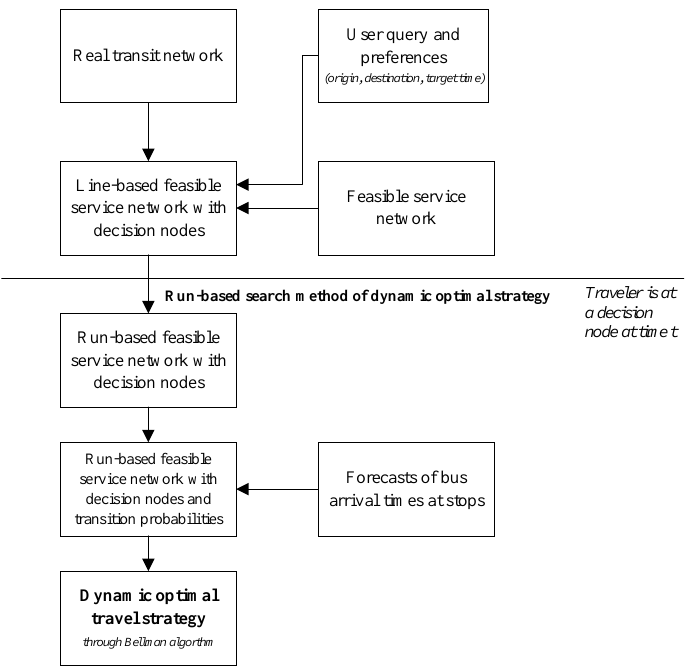
Figure 8. Procedure steps for searching dynamic optimal strategy.